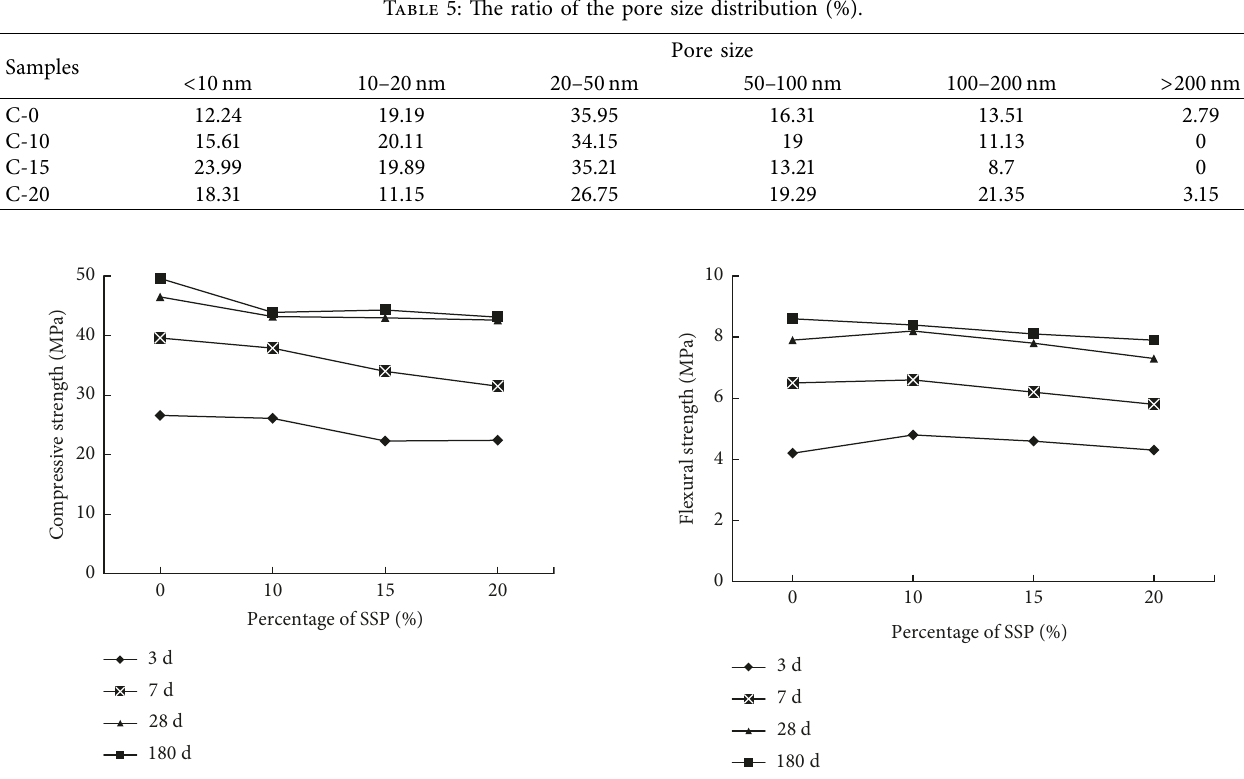
Figure 10: The compressive strength of mortar. Figure